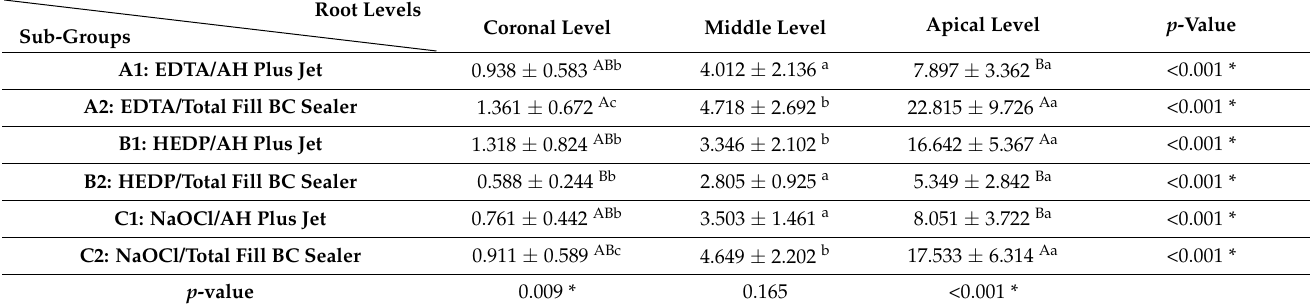
Table 3. Comparisons of push-out bond strength means (in MPa) according to root levels and